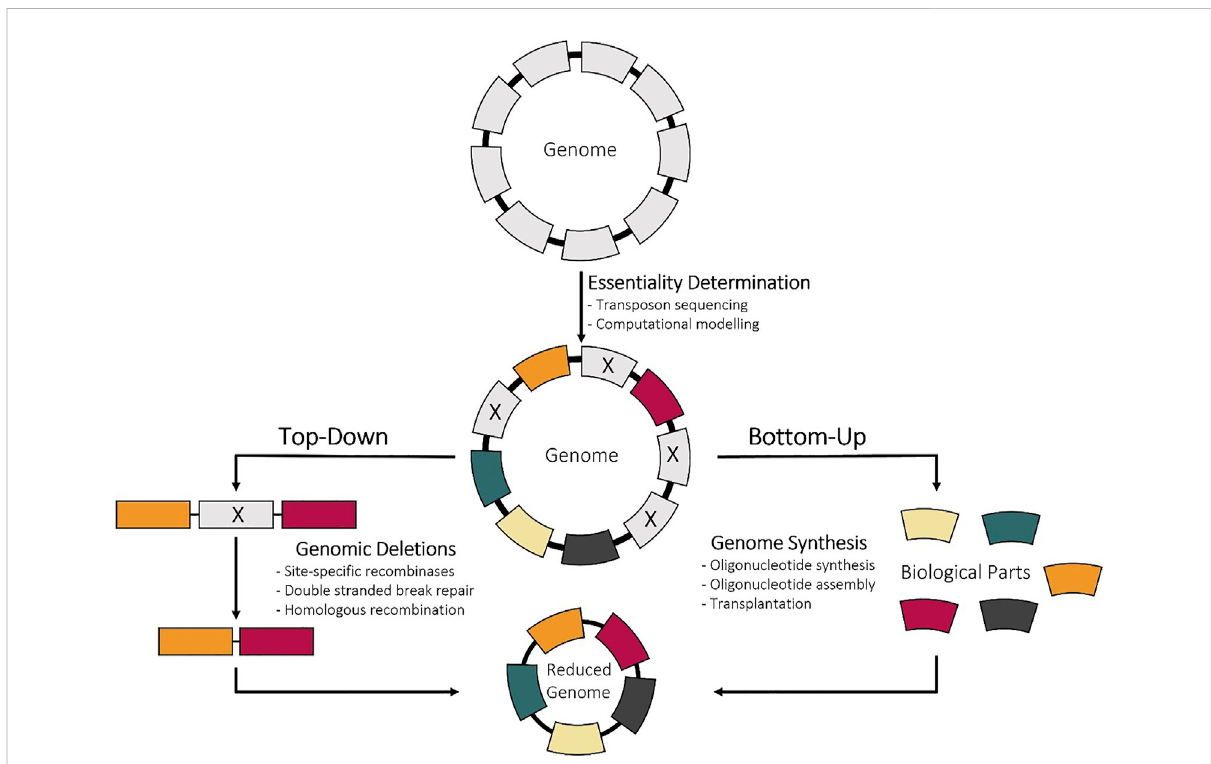
FIGURE 2 Experimental methods of determining gene essentiality. TnSeq inactivates a random gene by randomly inserting a transposon from a vector. LoxTnSeq deletes a random genomic region by inserting two transposons containing LoxP sites and activating recombination by Cre. CRISPRi-Seq inactivates a random gene by expressing a random gRNA and dCas9 that will bind and repress expression. For all three, the mutants will be pooled and subjected to various conditions followed by sequencing to identify remaining transposon location or guide